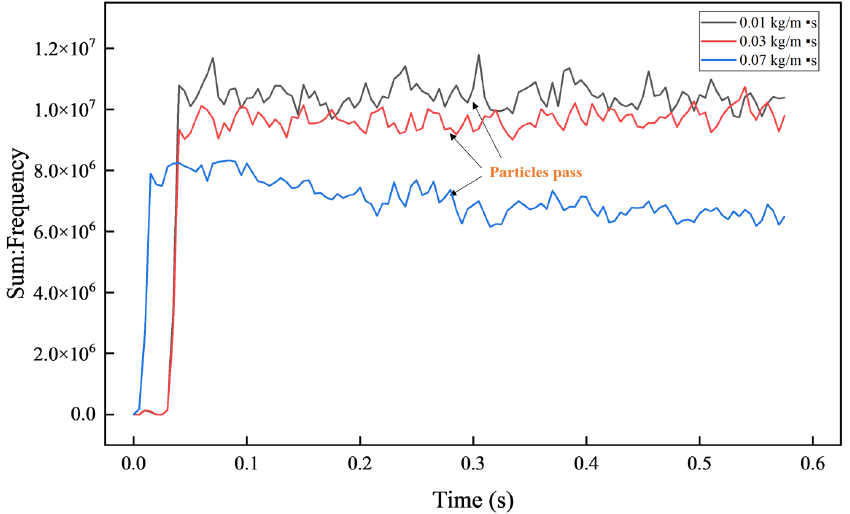
Figure 21. Flow properties of 1.4 mm LCMs under the action of drilling fluids with different viscos- ities.